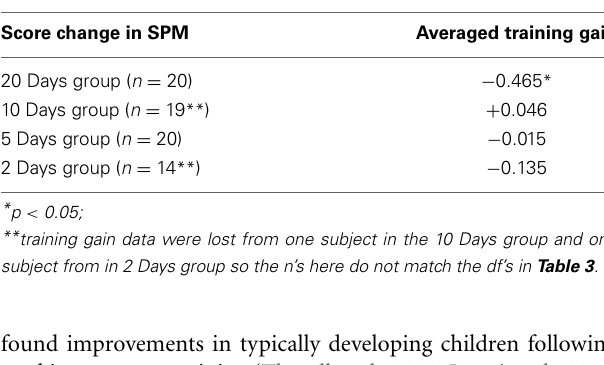
Table 5 | Correlation between training gain (RT decrease) and magnitude of training